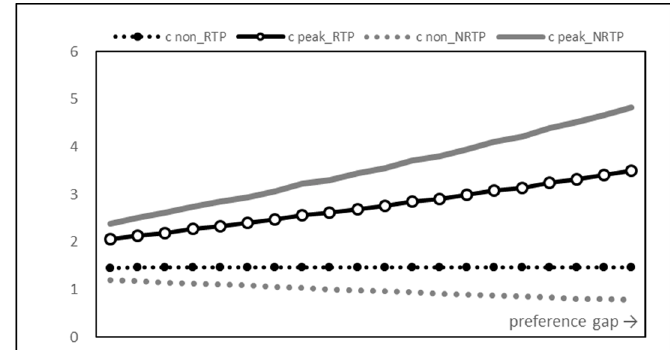
Figure 13. Supplier production cost graph.